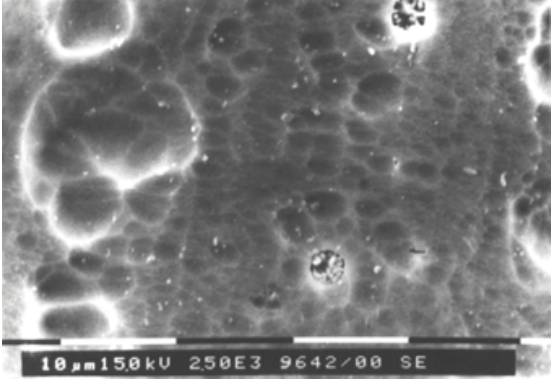
Fig. 2 SEM micromorphology of anodized Al plate